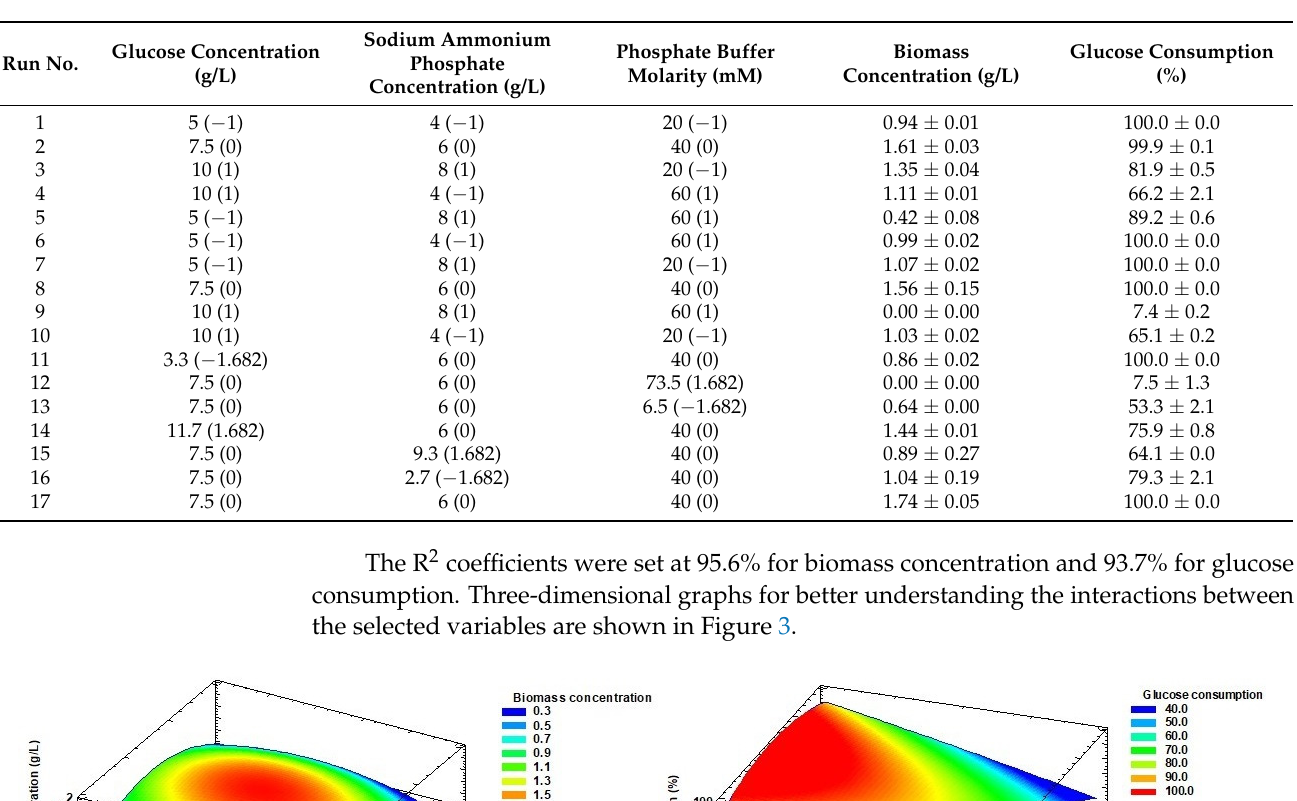
Table 1. Experimental design with actual and coded level of independent variables and the measured values of biomass concentration (g/L) and glucose consumption (%).